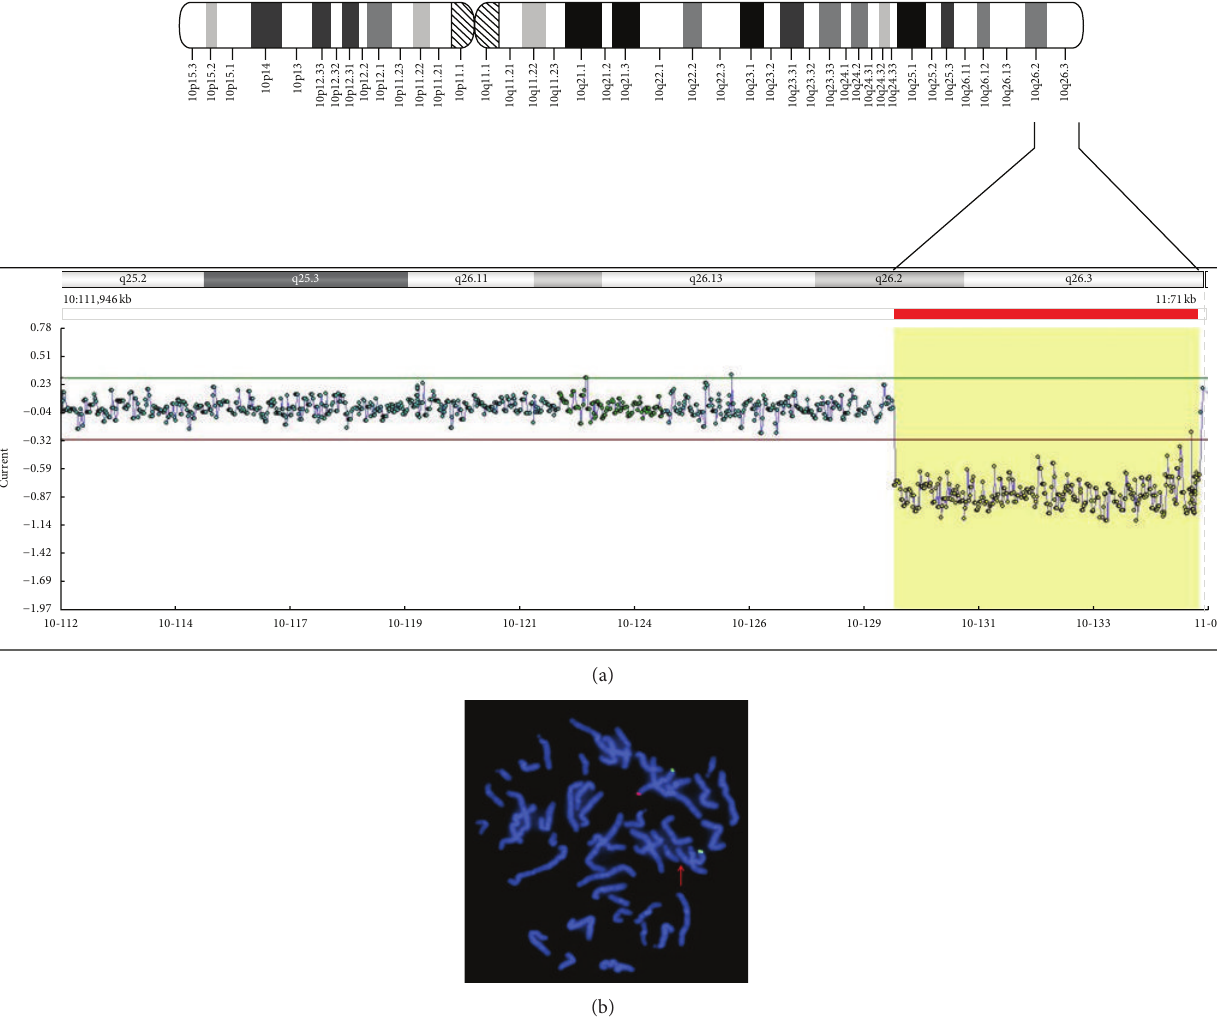
Figure 3: (a) Array-CGH analysis result demonstrating the 6.3 Mb distal deletion of chromosome 10 (q-arm) at chromosomal band 10q26.2 extending to band 10q26.3. (b) FISH analysis of the index patient’s metaphases showing two signals of the 10p region and only one signal of the 10q